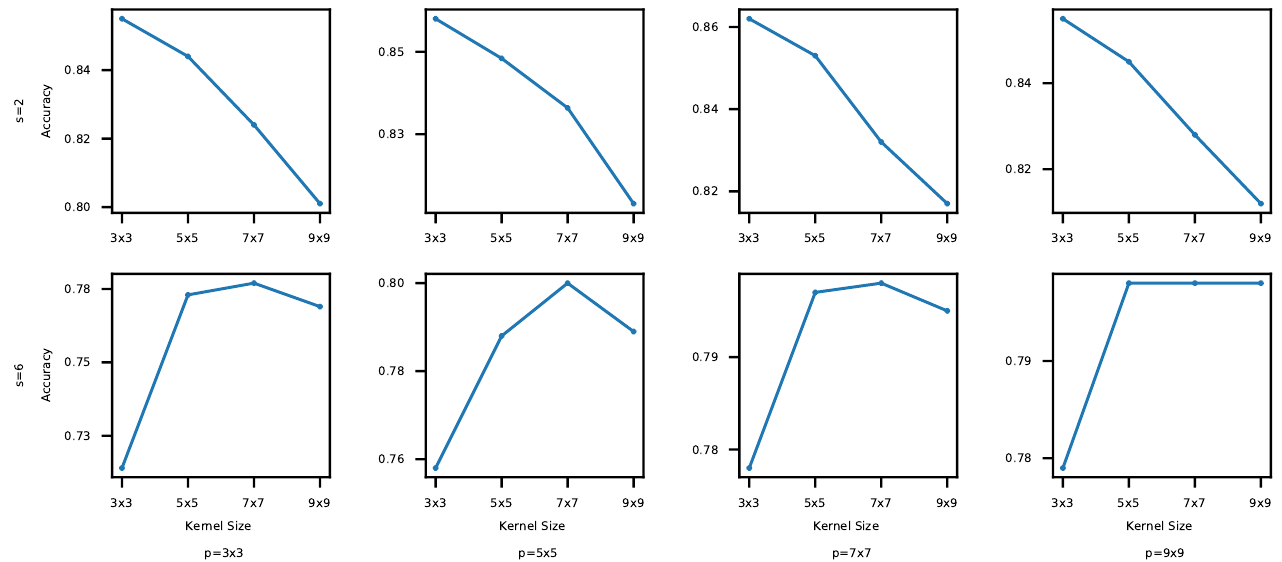
Figure 8. Kernel Size vs. Accuracy (CIFAR-10). A bigger kernel does not necessarily lead to higher accuracy, even though it has a longer execution time as plotted in Figure 7. Thus, finding an appropriate kernel size for certain s and p values is important to strike a balance between the inference time and